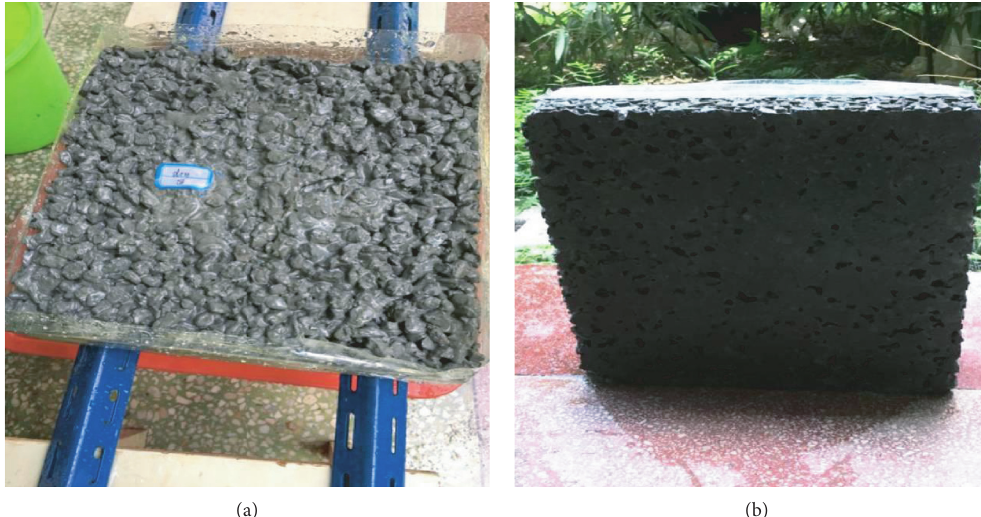
Figure 8: Ordinary concrete specimen after the test. (a) Specimen surface ponding is about 0.8 cm after the test. (b) The other side of the specimen is dry after the test.